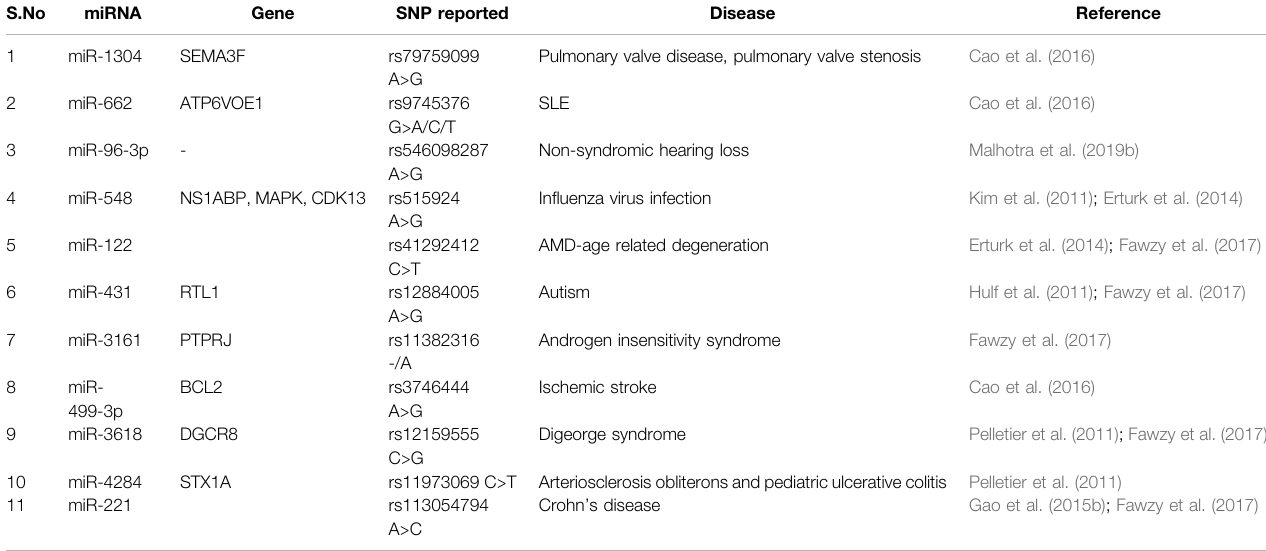
TABLE 5 | SNPs reported in seed sequence of miRNA involve in various disease.